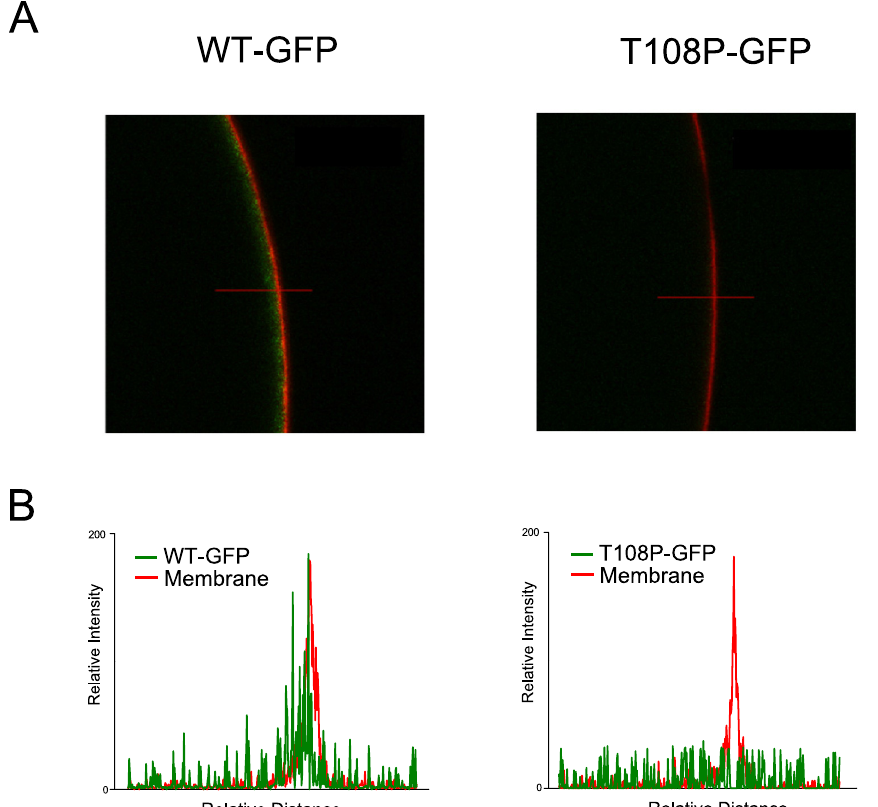
Fig 5. T108P reduces trafficking to the cell membrane. Confocal microscopy of GFP-tagged WT and mutant TASK-2 channels. (A) WT TASK-2 and T108P tagged with GFP at the C-termini expressed in oocytes. The red fluorescent signal (Wheat Germ Agglutinin CF633) indicates the location of the cell membrane. WT channels tagged with GFP (green) exhibit a clear membrane-associated fluorescence, whereas the mutant T108P channels showed no membrane localization, and no GFP fluorescence in any other part of the oocyte. (B) Representative relative signal-intensity profiles for oocytes expressing WT or T108P mutant channels. Intensities were determined along the cross-sections indicated by the red lines in panel A.